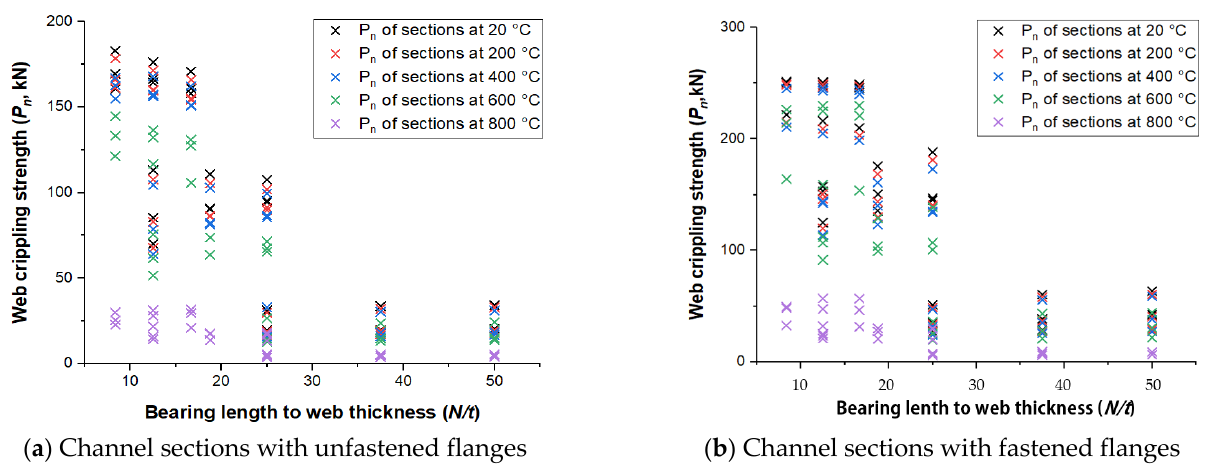
Figure 10. Ratio of N/t against web crippling strength.